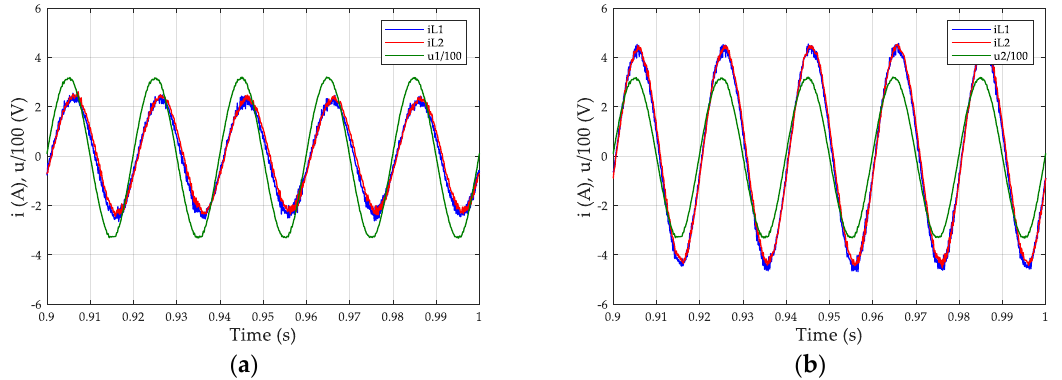
Figure 7. Voltage in the load bus and current in both reactances of converter LCL filter: ( a ) Prosumer 1; ( b ) Prosumer 2.